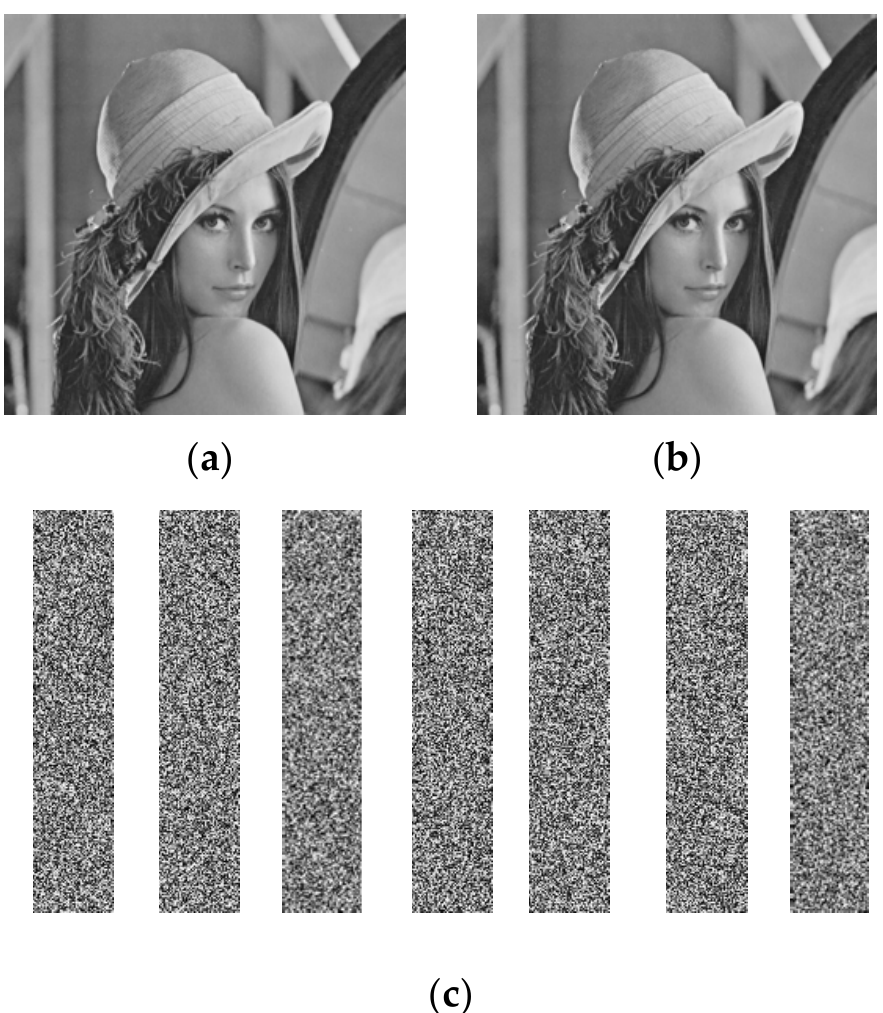
Figure 5. The proposed implementation of (5,7)-ISS scheme based on matrix operations: ( a ) the secret image; ( b ) the recovered image; ( c ) 7 shadows.